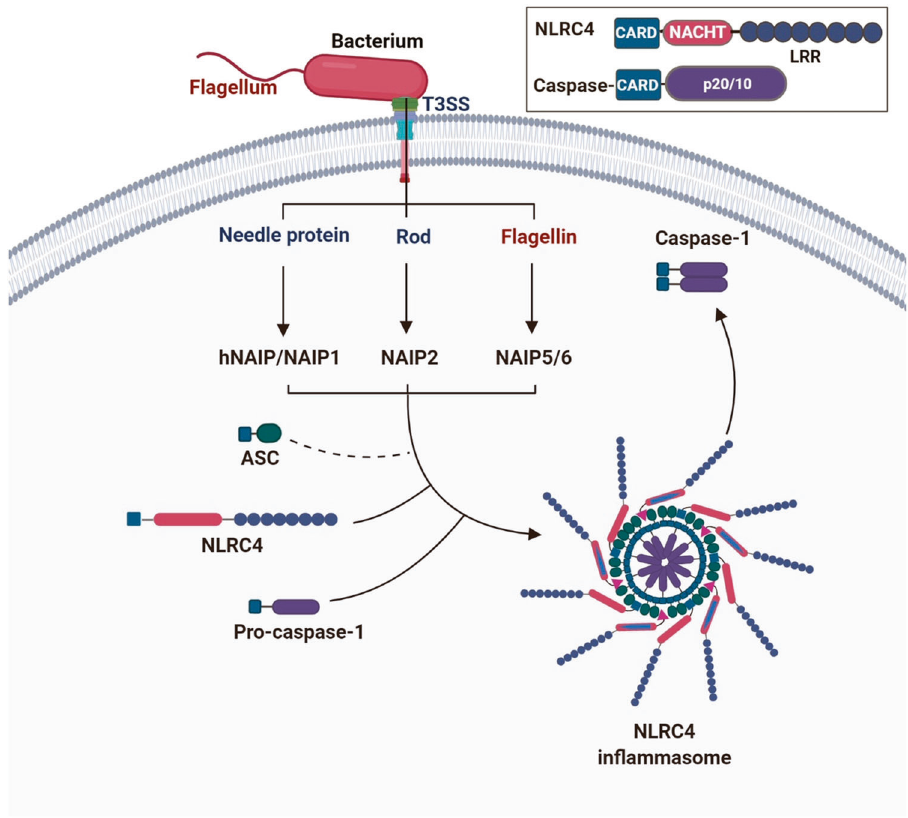
Fig. 2 Mechanisms of NLRC4 in fl ammasome assembly and activation. The bacterial ligands such as needle protein, rod, and fl agellin bind to NAIP proteins. Ligand-bound NAIP then interacts with NLRC4 to form the in fl ammasome through oligomerization. NLRC4 recruits pro- caspase-1 to the in fl ammasome via CARD – CARD interaction. Inset: NLRC4 in fl ammasome